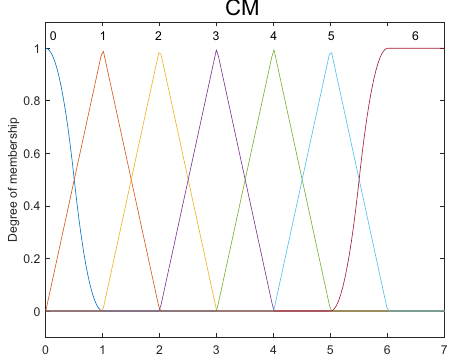
Figure 10. Inputs memberships functions of variable current mode